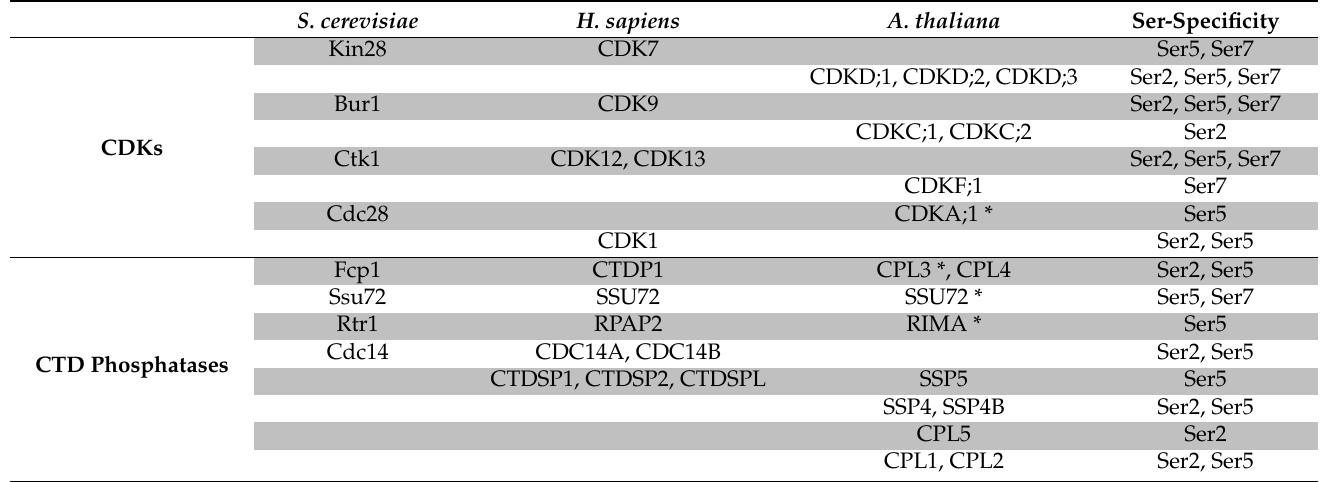
Table 1. CDKs and CTD phosphatases with known CTD Ser activities in yeast, Arabidopsis, and human. * Denotes the CTD phosphatases not yet studied regarding their Ser dephosphorylation